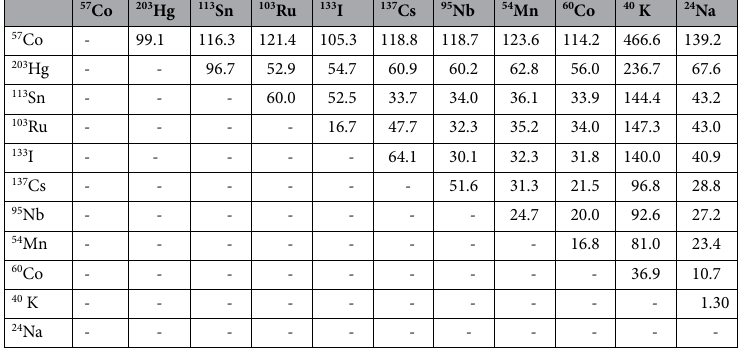
Table 5. Upper limit of simultaneously identified relative activities of gamma sources in distance of 1.0 m from center of gamma